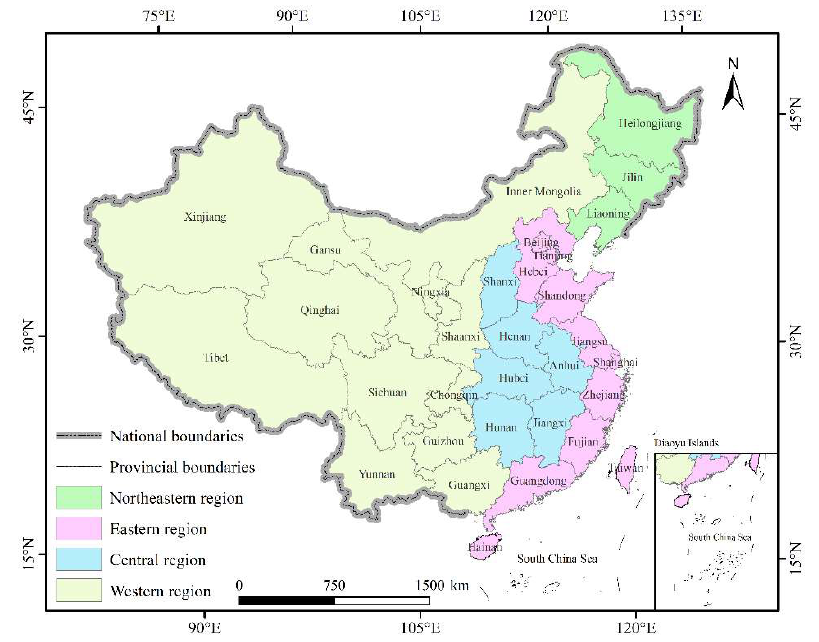
Figure 1. Distribution of the study area.